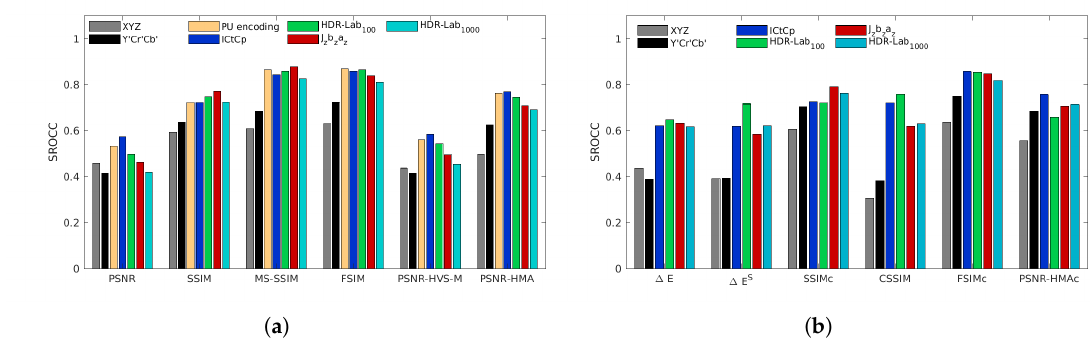
Figure 12. SROCC performances for the Narwaria et al. database for color-blind quality metrics ( a ) and for color quality metrics ( b